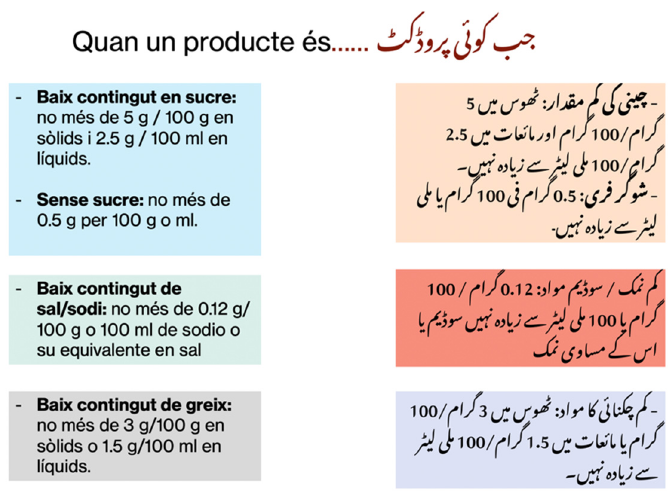
Figure 5. Explanation to analyse and interpret food labels.